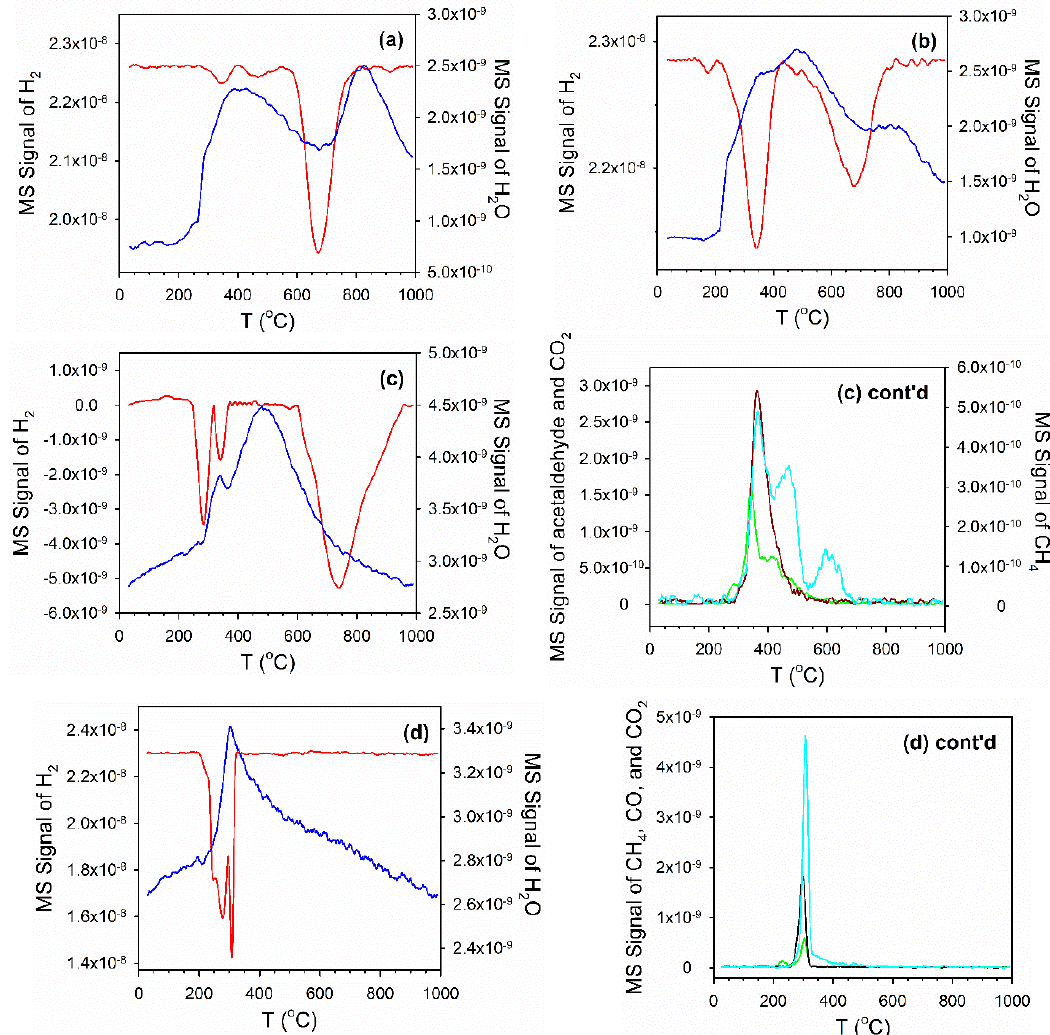
Figure 4. H 2 -TPR profiles with the mass spectra analysis of the exhaust gas for 12% Co/SiO 2 catalysts prepared with cobalt acetate, including ( a ) calcined, ( b ) calcined promoted with 0.5% Pt, ( c ) uncalcined, and ( d ) uncalcined promoted with 0.5% Pt. (red), H 2 (blue), H 2 O, (dark red), C 2 H 4 O (cyan), CH 4 (green), CO 2 , and (black) CO.